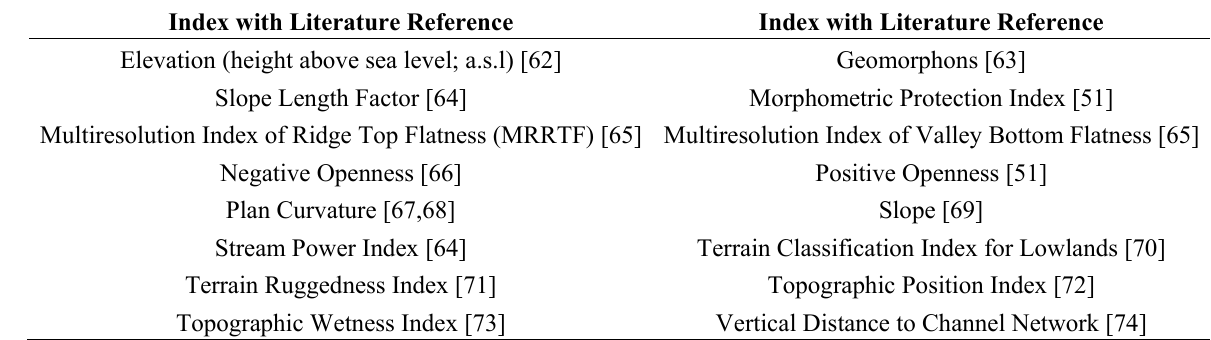
Table 3. Topographic indices.